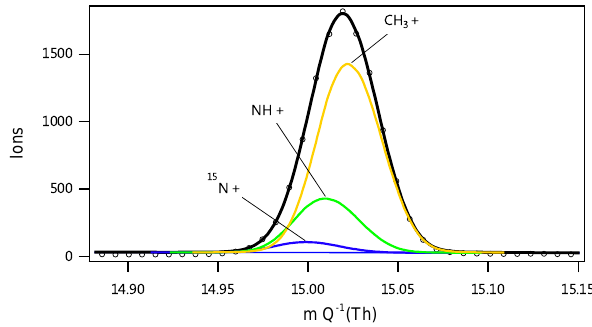
Figure 6. The isobaric peaks 15 N + ( m/Q = 14.9996Th), NH + ( m/Q = 15.01035Th) and CH + ( m/Q = 15.0229Th) at 15Th 3 have peak separations of 0.5 half-widths for mass resolving power m/(cid:49)m =